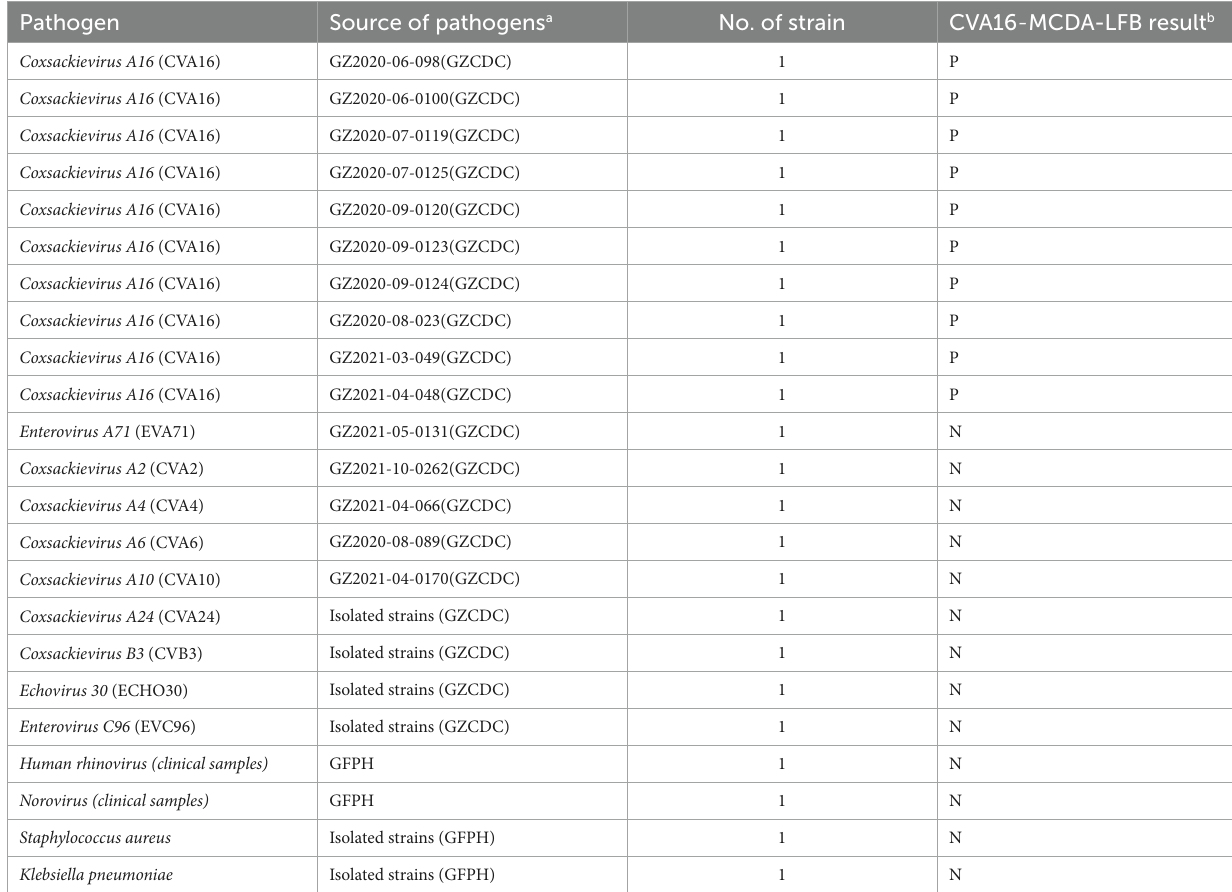
TABLE 1 Pathogens used in the current study.